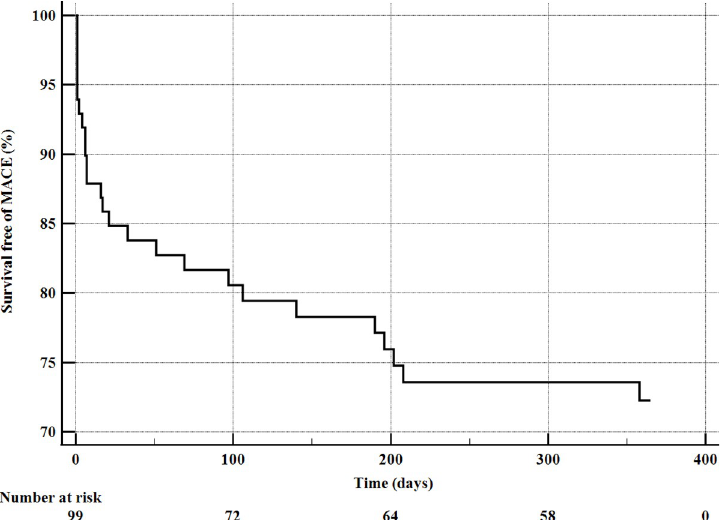
Fig 2. Kaplan–Meier curves for MACE in patients with CAP treated by CS implantation. MACE- major adverse cardiac events.